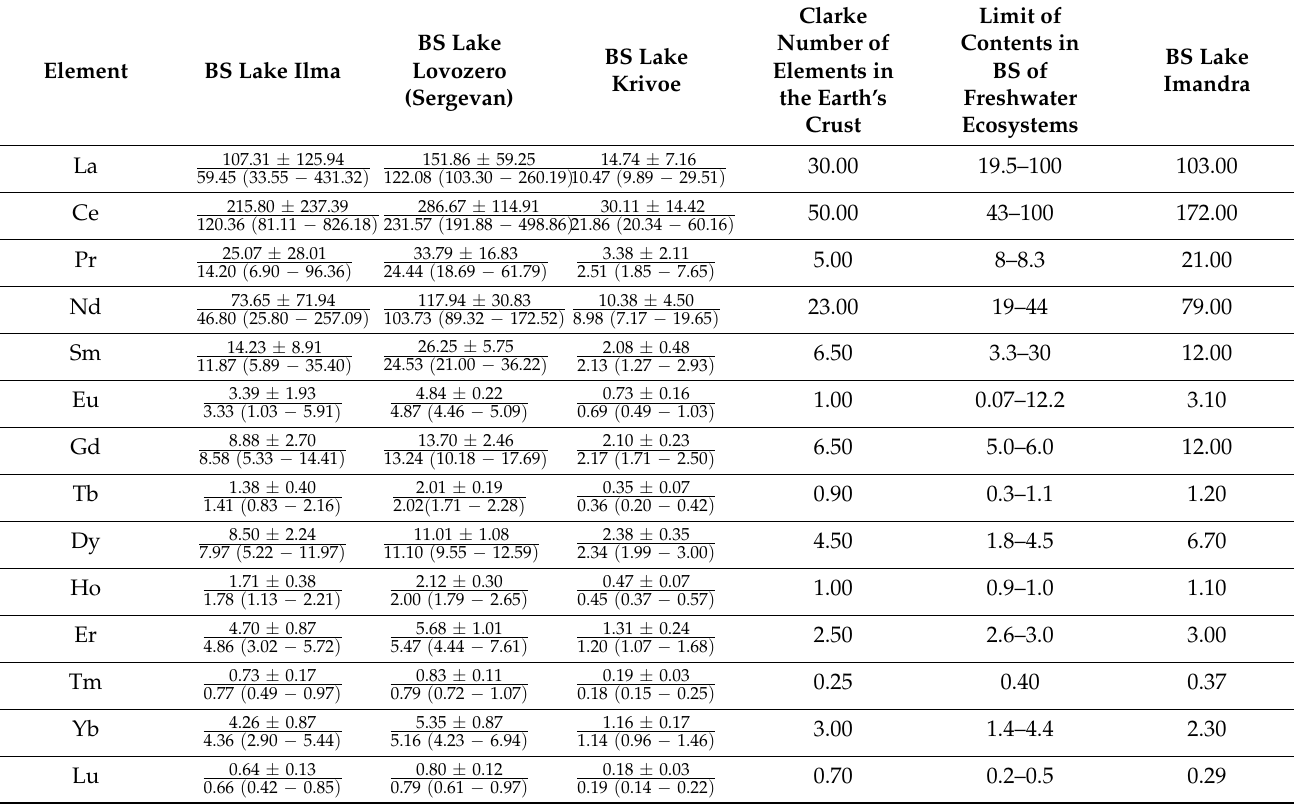
Table 6. The content of REEs in BS (layer 0–9 cm) of the studied lakes and other objects,